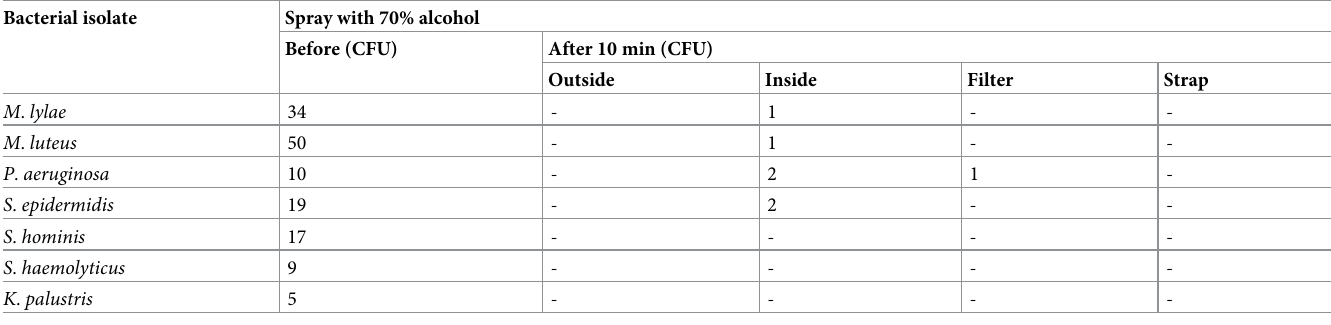
Table 3. Bacterial isolates from the masks after spraying with 70% alcohol. Bacterial